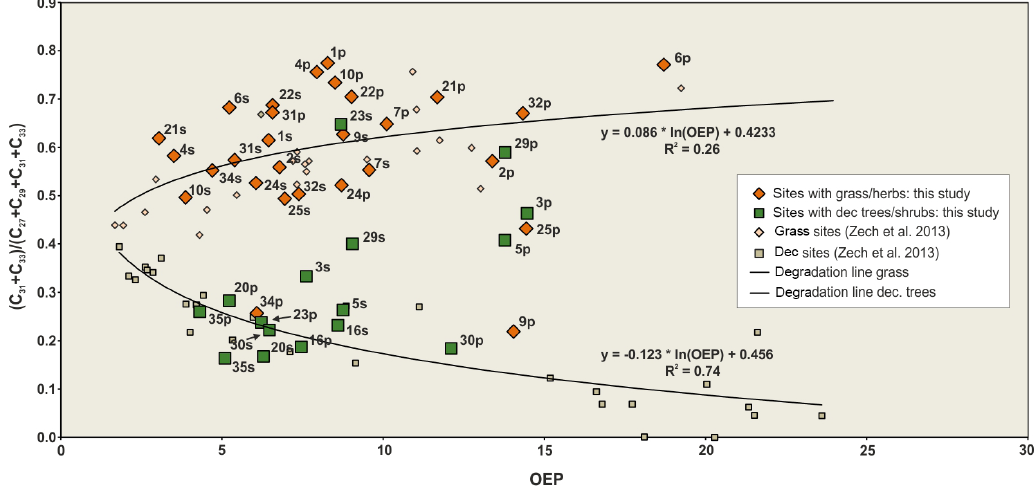
Figure 6. End-member plot for the n -alkane ratio ( C 31 + C 33 )/( C 27 + C 29 + C 31 + C 33 ) . The n -alkane results from plant and topsoil samples from eastern Georgia were integrated into a dataset from recent grassland and forest sites from central and southeastern Eu- rope (Zech et al., 2013). Degradation line for grass/herbs: y = 0 . 086 · ln ( OEP ) + 0 . 4233. Degradation line for deciduous trees/shrubs: y =− 0.123 · ln ( OEP ) + 0 .